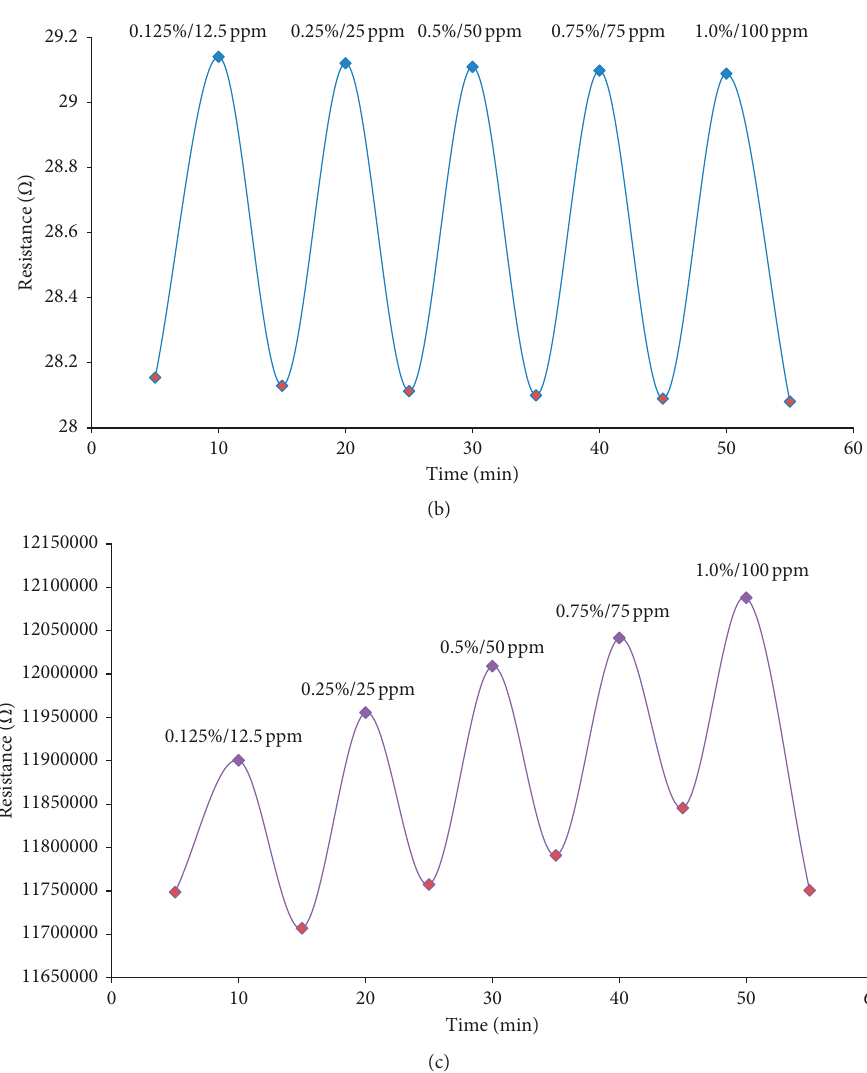
Figure 3: Resistance changes of (a) pristine CNT, (b) CNT-carboxylic, and (c) CNT-amide towards benzene gas at room